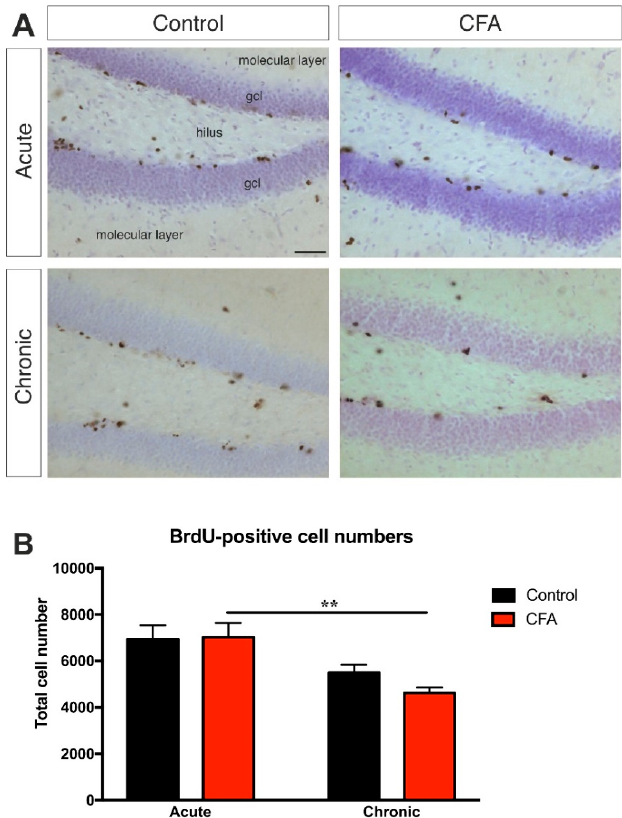
Figure 5. The effect of chronic arthritis on cell proliferation in the dentate gyrus. ( A ) Representative images demonstrating BrdU-immunopositive cells in the dentate gyrus of control and CFA-treated mice. Scale bar: 50 µm for all images. ( B ) Results of the systematic cell quantification data. Graphs represent the total number of BrdU-positive cells in both hemispheres combined. Animals in the chronic CFA treatment group had significantly reduced dentate cell proliferation compared to the acute CFA-treated group. Two-way ANOVA (time × CFA treatment) revealed a highly significant time effect but no effect of CFA-treatment, and the results of the post-hoc Tukey’s test is shown on the graph: ** p < 0.01. Abbreviations: 5-bromo-2’-deoxyuridine (BrdU); complete Freund’s adjuvant (CFA); granule cell layer (gcl).